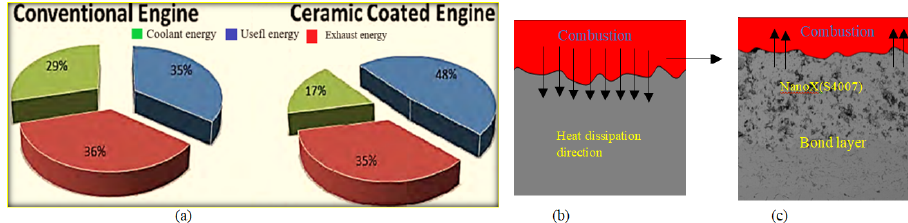
Figure 1: (a) Energy balance for diesel engine, (b) Schematic diagram of the diesel engine part before coating and (c) After